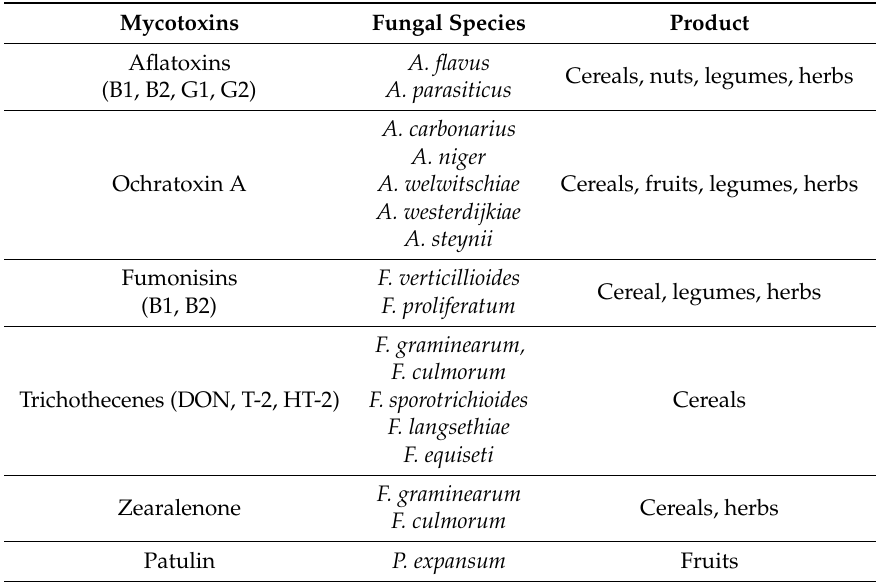
Table 1. Main mycotoxins occurring in the raw products used to prepare functional beverages. Their most relevant producing fungi in these matrices are also